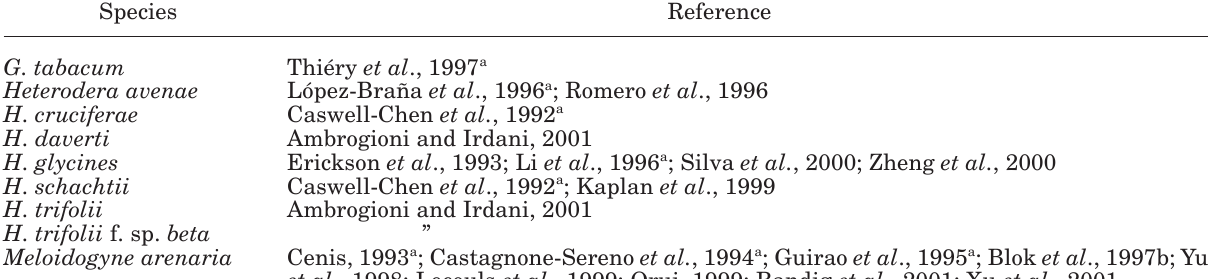
Table 9. Plant-parasitic nematodes species characterized by